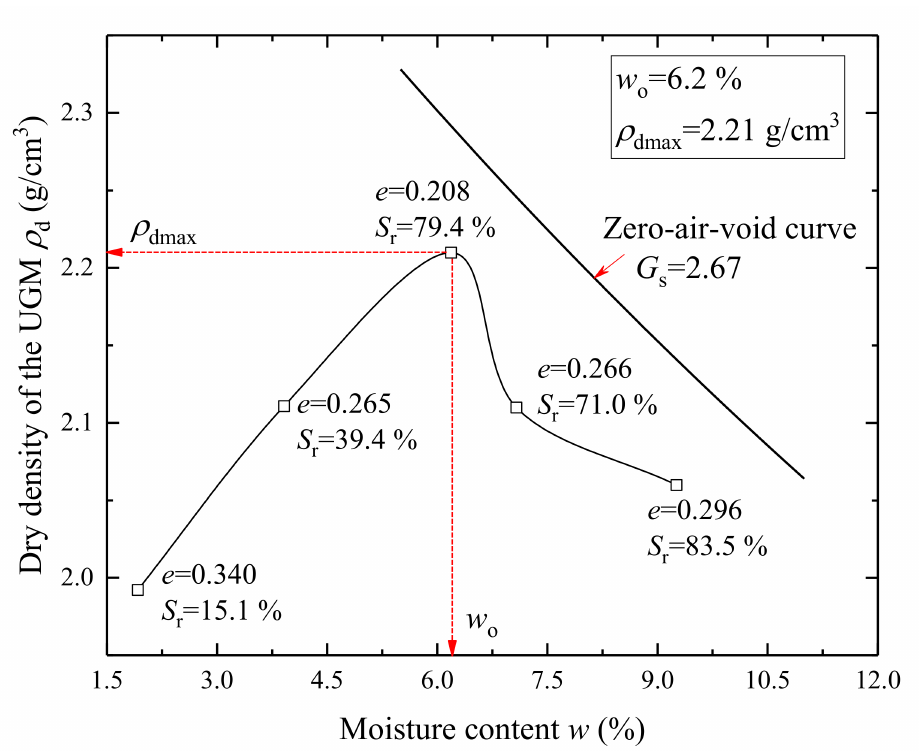
Figure 2. Compaction curve of the